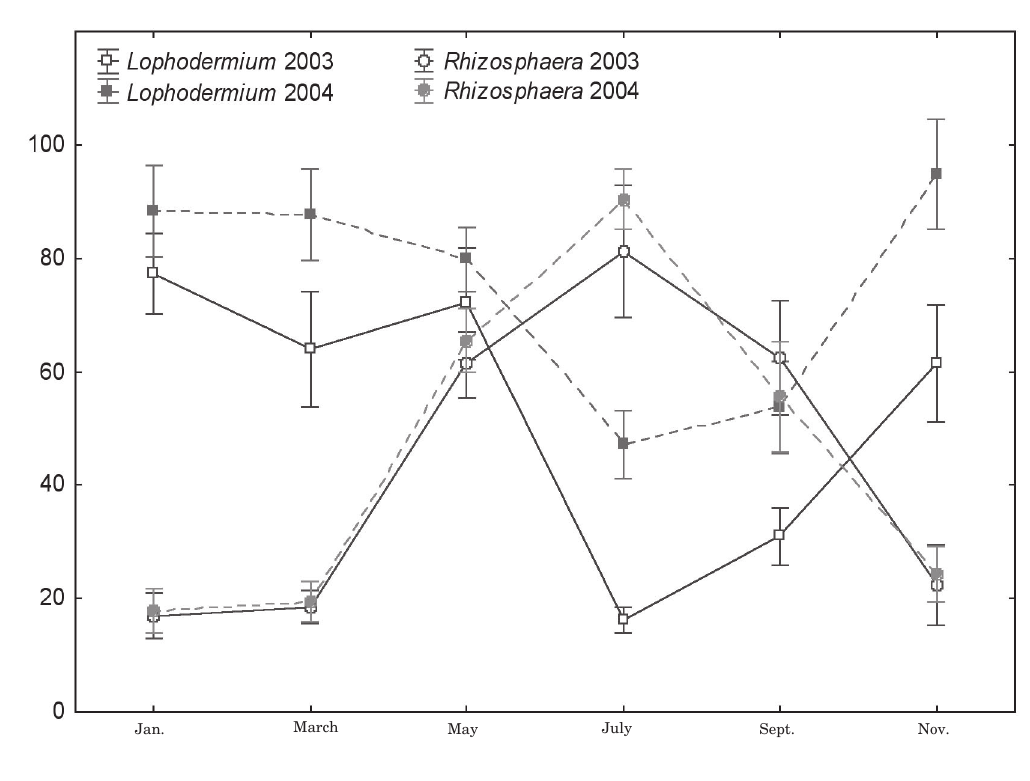
Fig. 2. Frequency of needles infected with Lophodermium piceae and Rhizosphaera kalkhoffii at site A, during 2003 and 2004. Fungal trends are the means of 60 trees, calculated every two months. The data point values of a month, with standard errors indicated by whiskers, relate to that and the